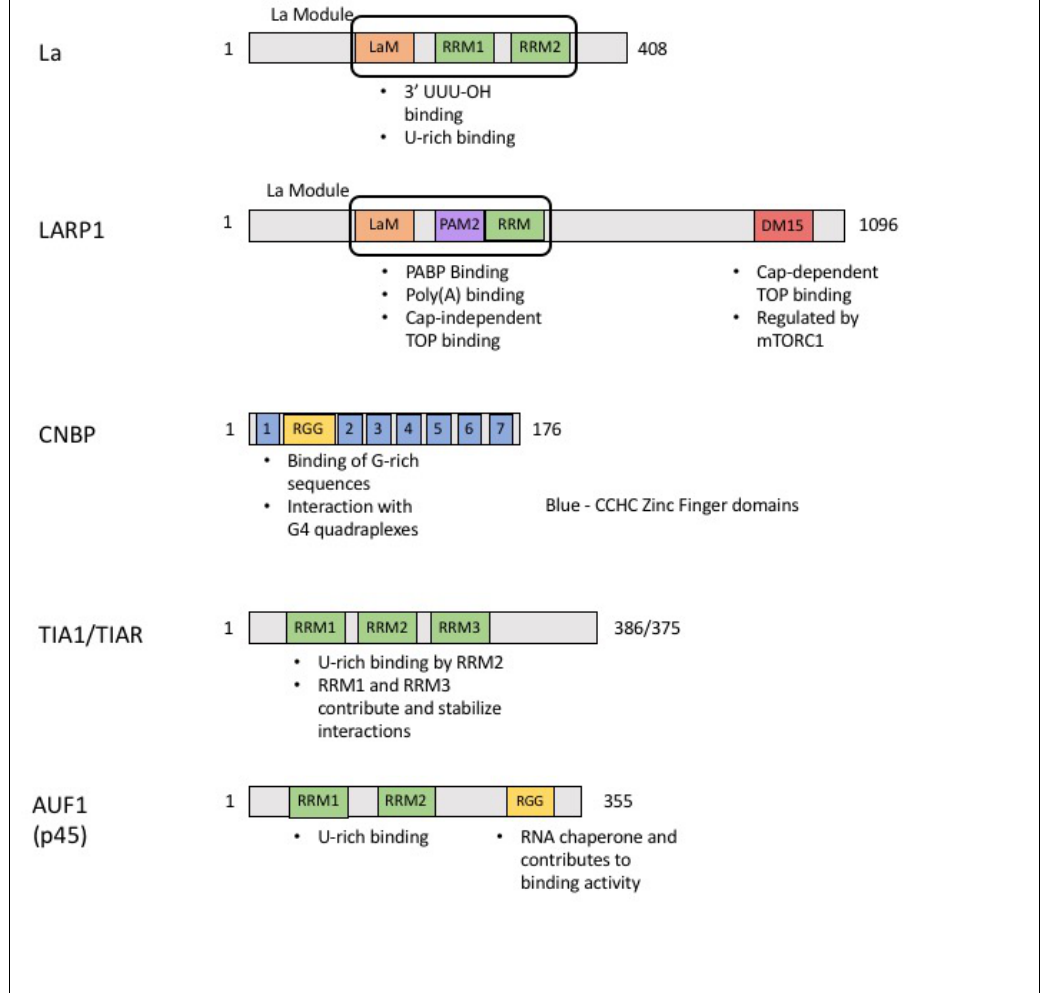
Figure 2. Schematics of 5' TOP motif binding proteins and their RNA binding domains. La possesses the La Module consisting of the La Motif (LaM, orange) as well as two RNA recognition motifs (RRM, green). LARP1 also has the La module but with a poly(A) binding protein (PABP)-interacting motif (PAM2, purple). There is also the DM15 (red) domain in the C-terminal region that is required for 5' TOP motif and cap binding. Cellular Nucleic Acid Binding Protein (CNBP) contains seven CCHC-zinc finger repeats (1-7, blue) as well as an arginine / glycine rich motif (RGG, yellow). AUF1 has four isoforms, p45 is the chosen canonical isoform shown here. AUF1 contains two RRMs as well as an RGG motif. All four isoforms contain the RRMs. In p42 and p45, the RGG is interrupted by an alternatively spliced